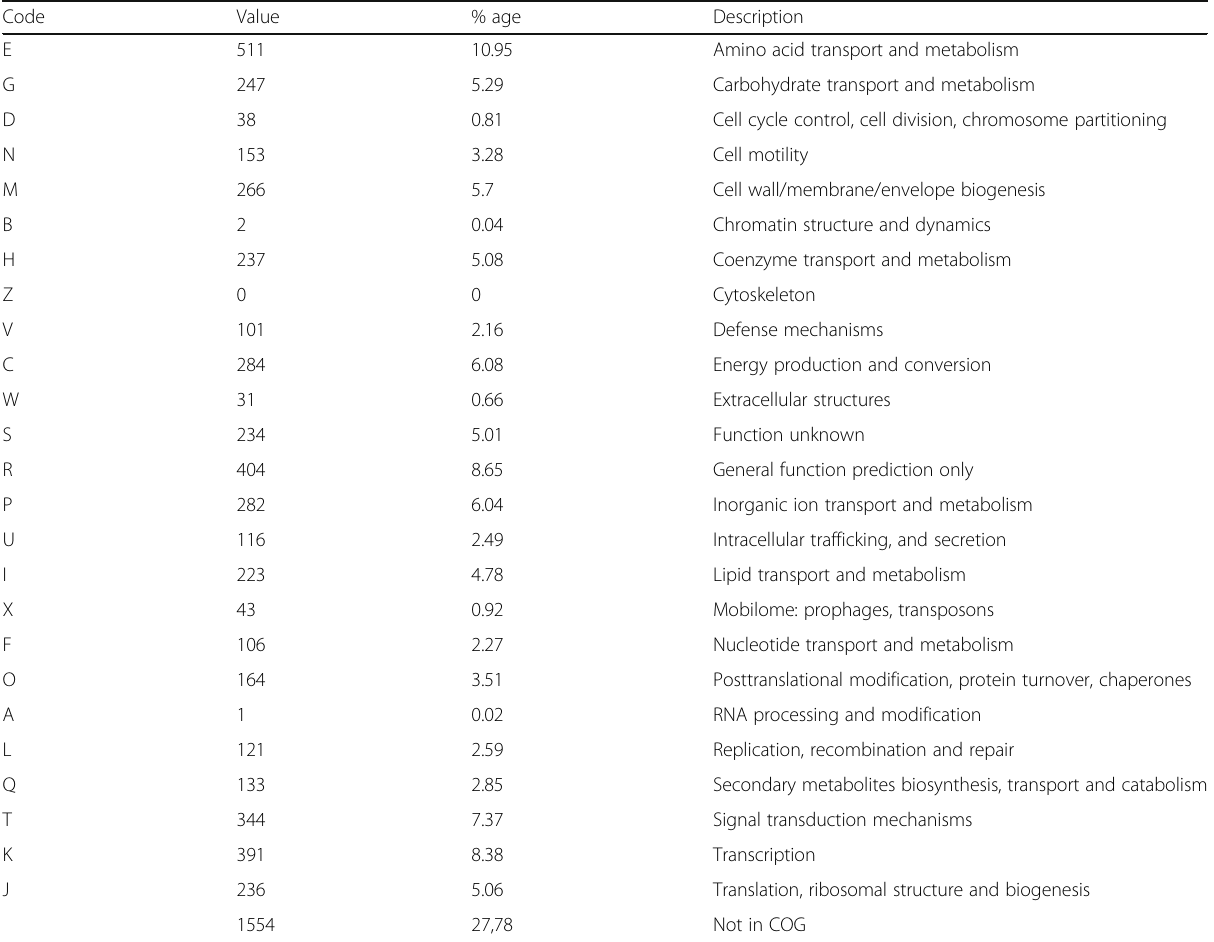
Table 4 Number of genes associated with general COG functional categories